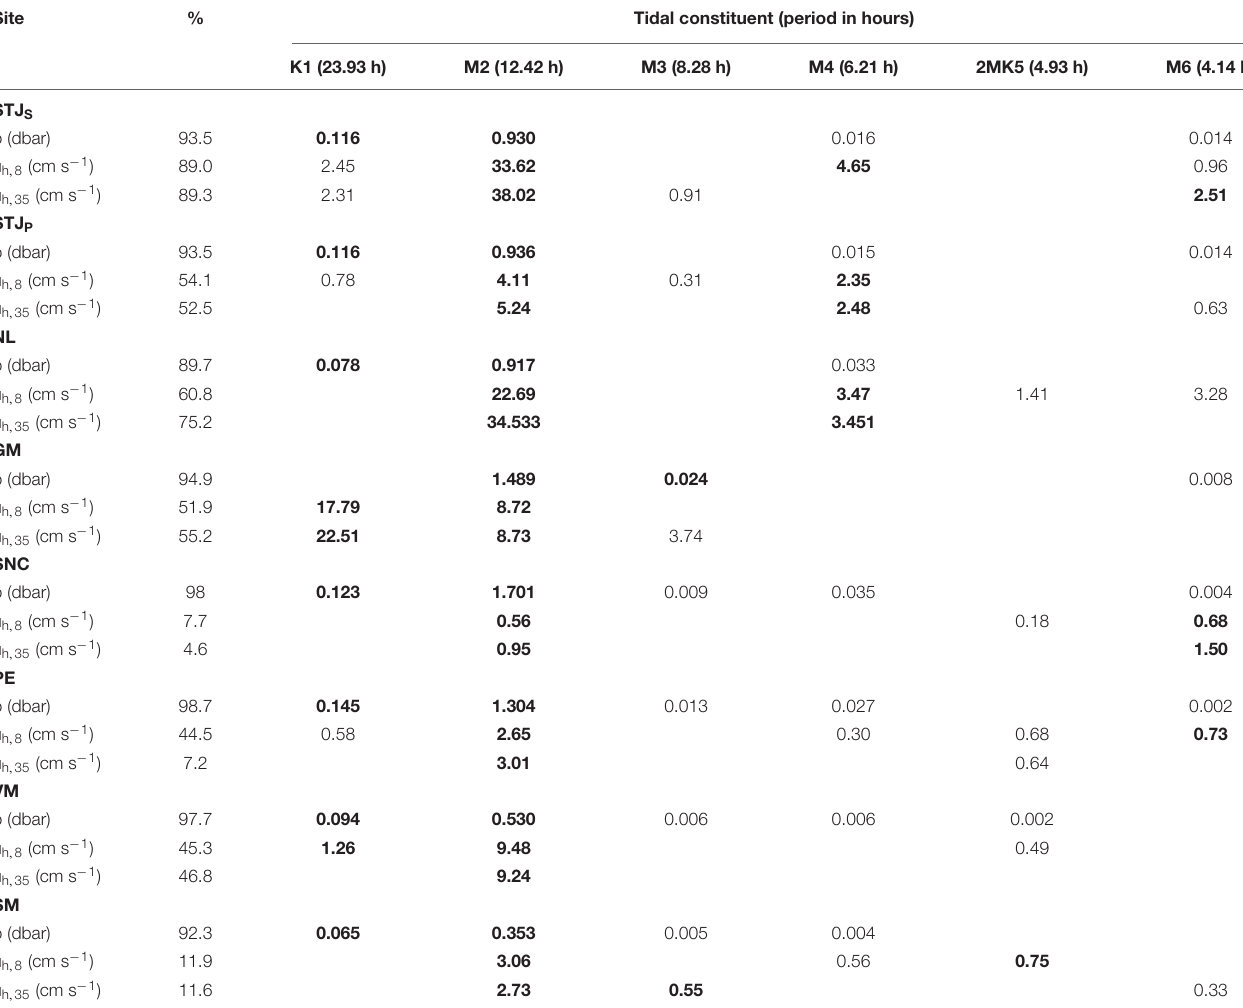
TABLE 4 | Tidal analysis for bottom pressure and flow record based on the harmonic analysis toolbox T_Tide (Pawlowicz et al., 2002). Site % Tidal constituent (period in